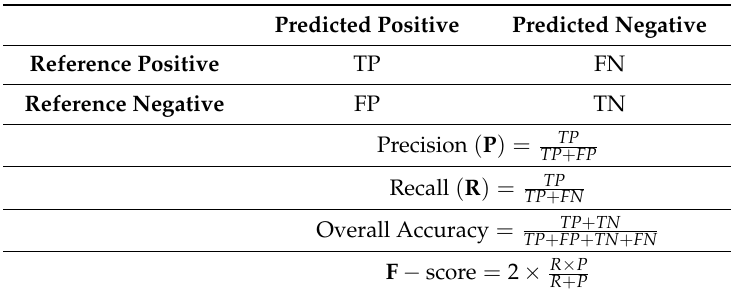
Table 4. Formulation for overall accuracy and